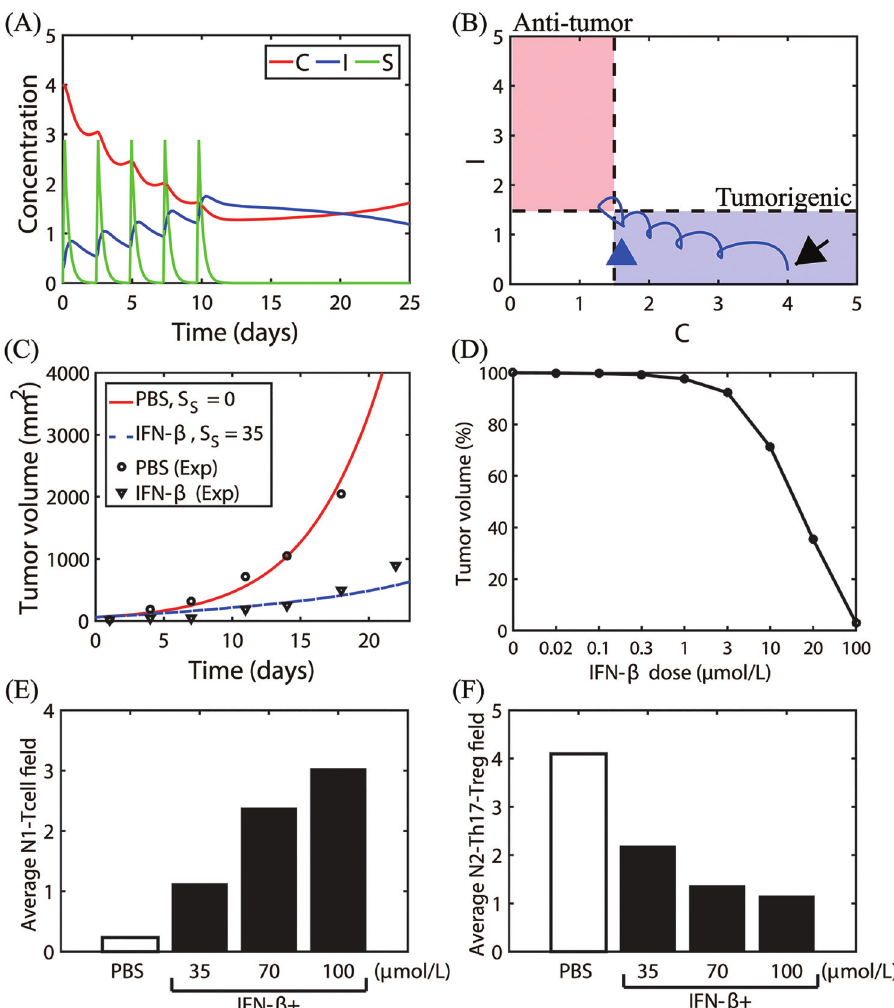
Fig 14. Therapeutic effect of IFN- β on tumor growth. (A) Time courses of the N2 complex level ( C ), N1 complex activity ( I ), and concentration of IFN- β ( S ) in response to a periodic injection of IFN- β on 0, 3, 5, 7, 9 days . (B) Dynamics of the core N1-N2 system corresponding to (A) in the C − I plane. Black arrow = initial position, blue arrowhead = terminal point at t = 25 days . (C) Time courses of tumor volume in control (PBS) and IFN- β + cases: Control (PBS) from the model (red solid line, S = 0), IFN- β injection case from the model (blue dashed line, S = 35), s s control (PBS) from experiments (empty circle), IFN- β injection case from experiments (triangle). (D) Tumor volume (%) at final time ( t = 25 days ) in response to various IFN- β injection levels ( S = 0, 0.02, 0.1, 0.3, 1.0, 3.0, 10, 20, 100 s μmol / L ). (E, F) Tumor-infiltrating CD8 T cells and Tregs. Average field of N1-Tcell (E) and N2-Th17-Tregs (F) over the time interval [0–12 days ], in the absence (PBS) and presence of IFN- β injections (35,70,100 μmol / L ). Initial conditions: C (0) = 4.0, I (0) = 0.3, S (0) = 0. Initial injection time: t 1 = 0. Parameters used: G = 0.4. All other parameters are fixed as in Table 2.